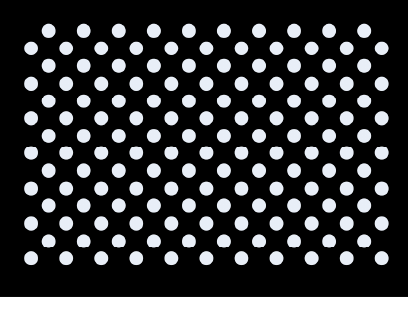
Figure 5. Design of the calibration board.